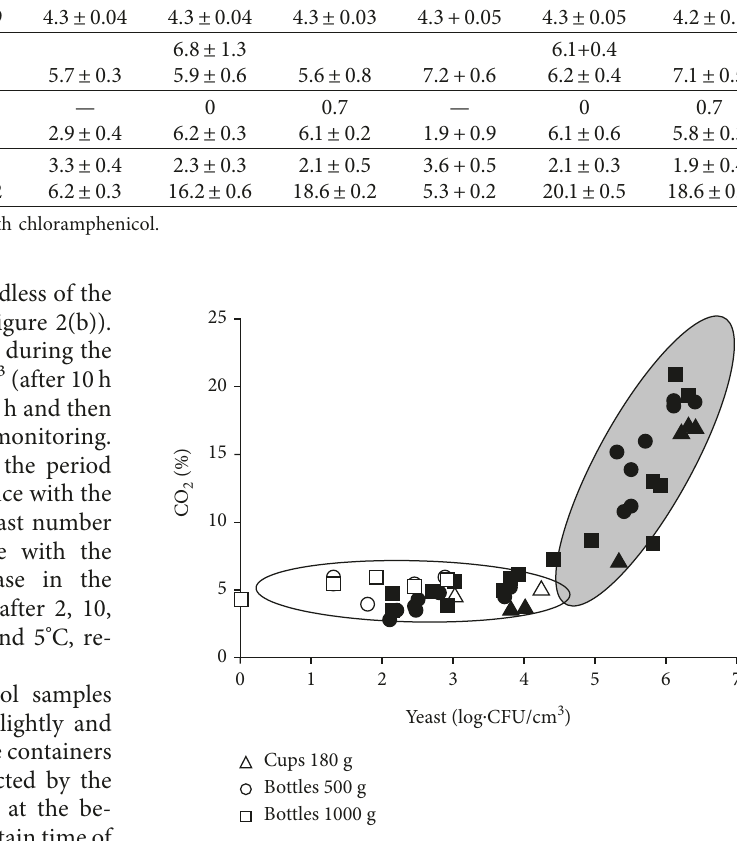
Figure 3: The relations between averaged values of CO 2 content in headspace and yeast level in the yogurt (“Vedro,” 2.8% milk fat) packed in PVC cups (180g) and the PVP bottles (500 g, 1000g) during incubation (30 ° C) of not-contaminated (open symbols) and contaminated with the yeast Candida kefyr (black symbols) sam- ples. Prediction area ellipses were defined by the coefficient of